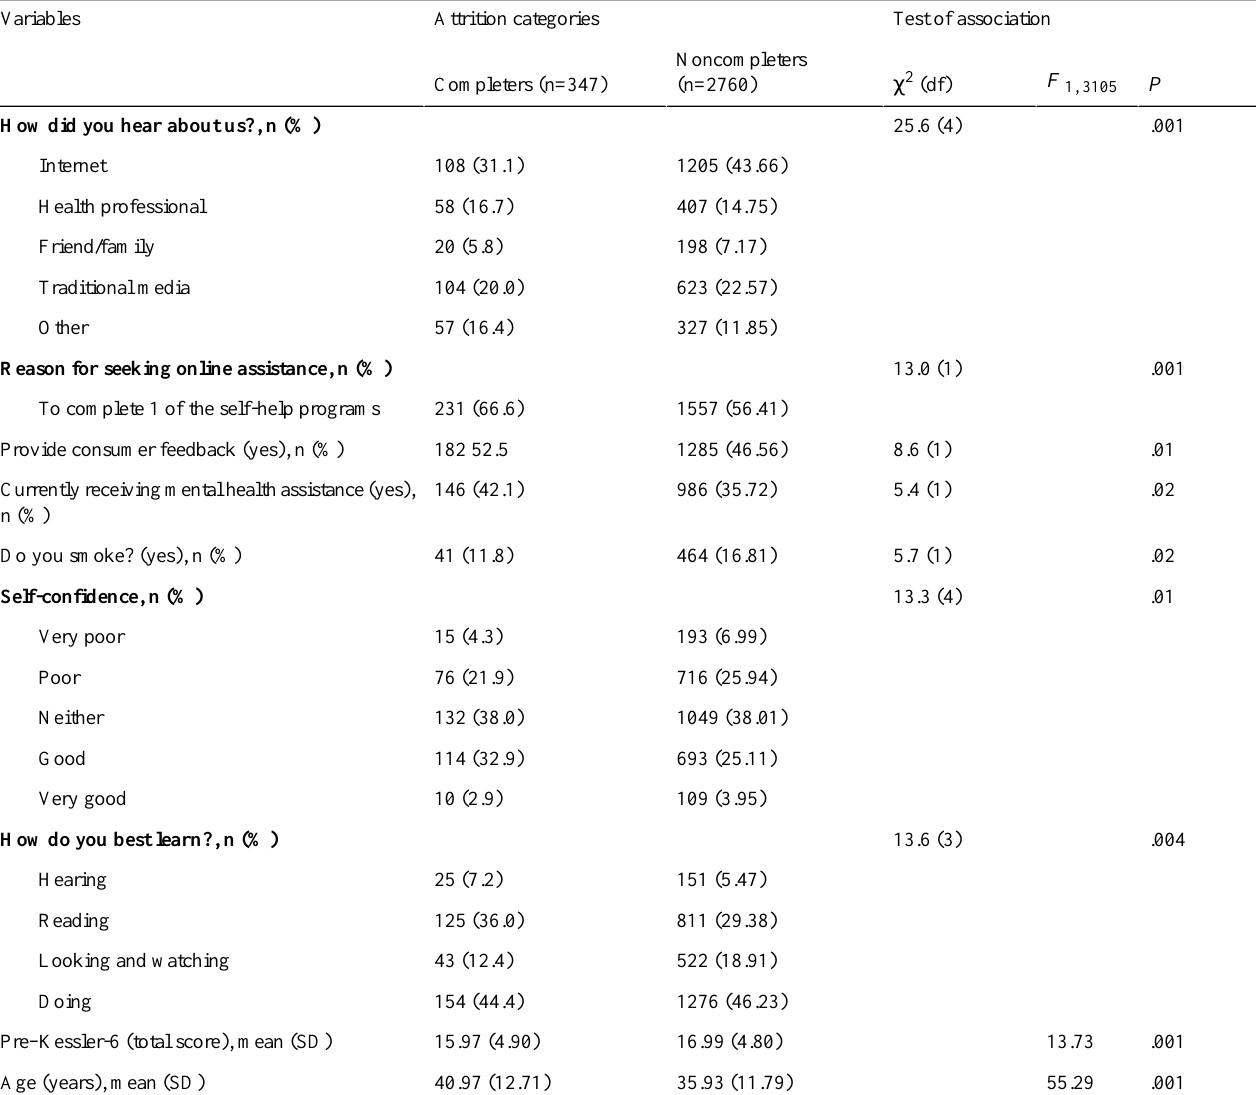
Table 2. Predictor analysis for attrition categories for posttreatment assessment completers and noncompleters for online self-help group (N=3107).